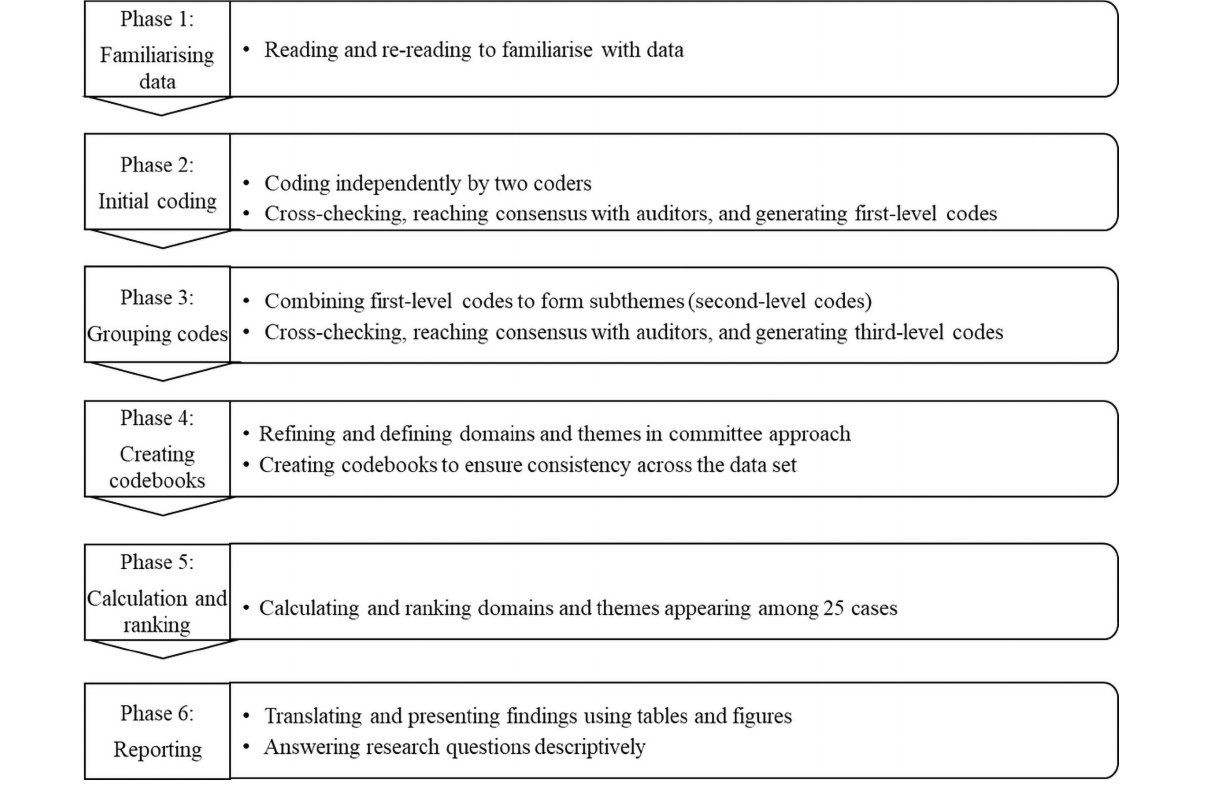
FIGURE 1 | Six phases of qualitative